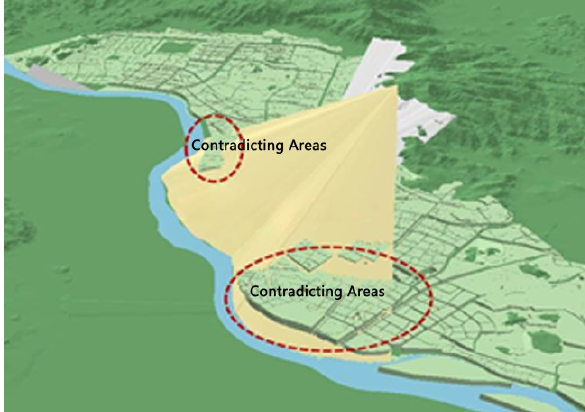
Figure 10. Contradicting Areas ( Wang Tong, Jiang Ying, Luo Wen, 2016)